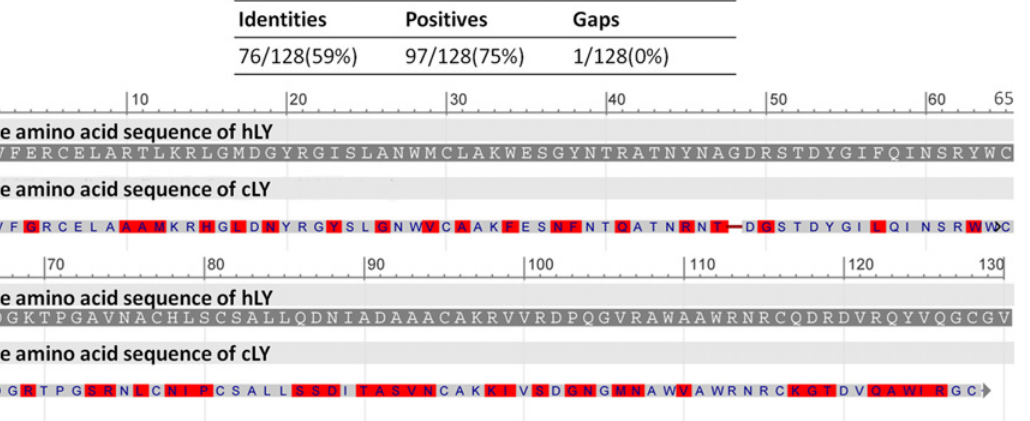
Fig 1. The alignment of the amino acid sequences of cLY and hLY protein. Red highlighted residues above the sequences represent the amino acid differences between the cLY and hLY protein. The alignment of the amino acid sequences was analysed using the Protein Blast (http://blast.ncbi.nlm.nih.